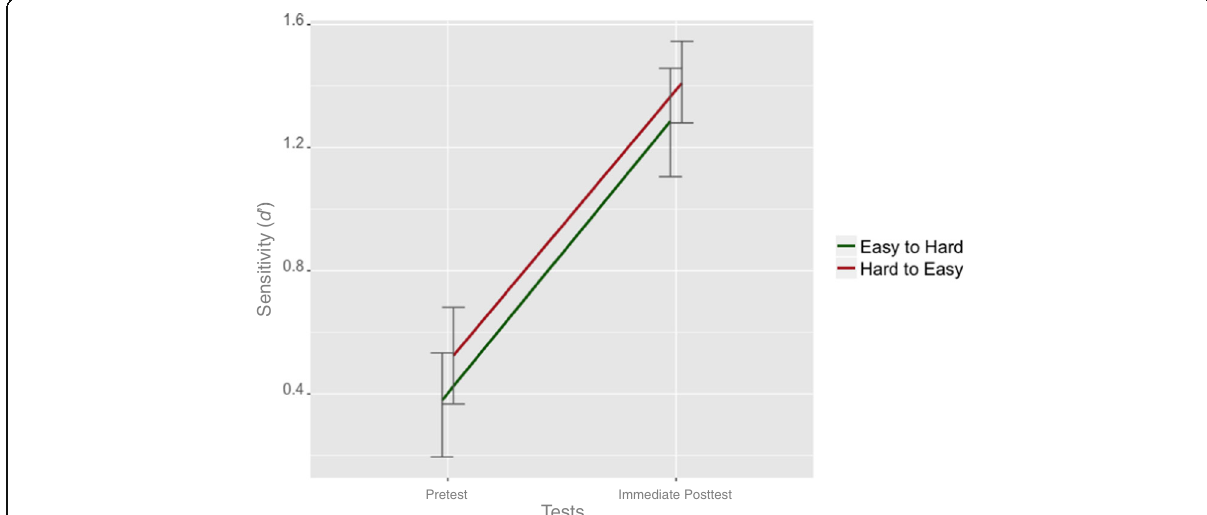
Fig. 6 The sensitivity (d ’ ) in the pretest and post-test of MDT for participants receiving the easy-to-hard and hard-to-easy training. Error bars stand for 95% confidence